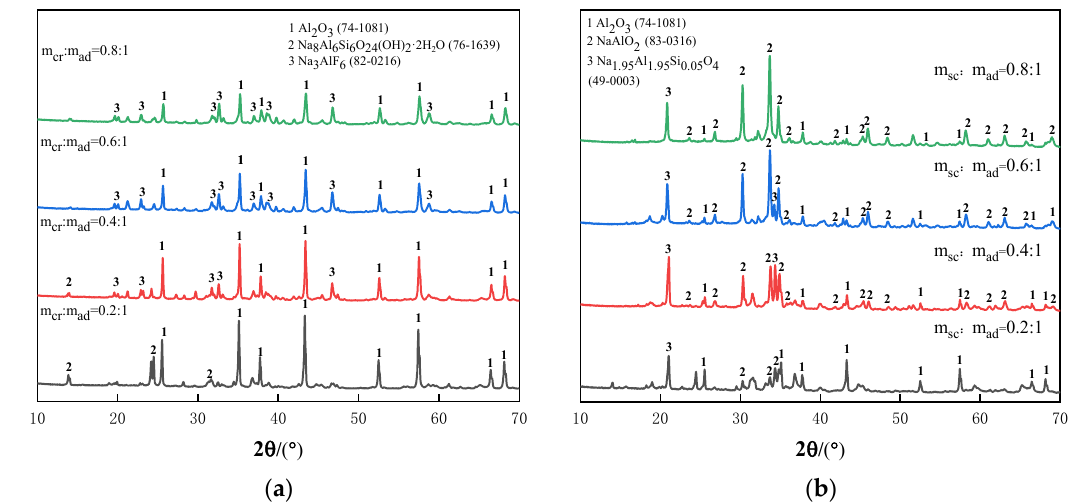
Figure 5. XRD patterns of different ingredient ratios. ( a ) XRD pattern of sample with cryolite; ( b ) XRD pattern of sample with sodium carbonate.